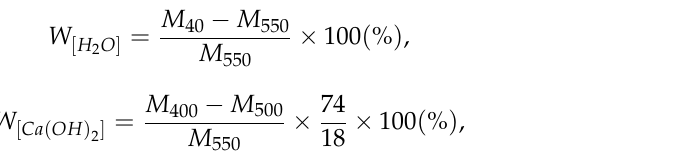
where M 40 , M 400 , M 500 , and M 550 are the dry weights of the sample at 40 °C, 400 °C, 500 °C, and 550 °C, respectively.